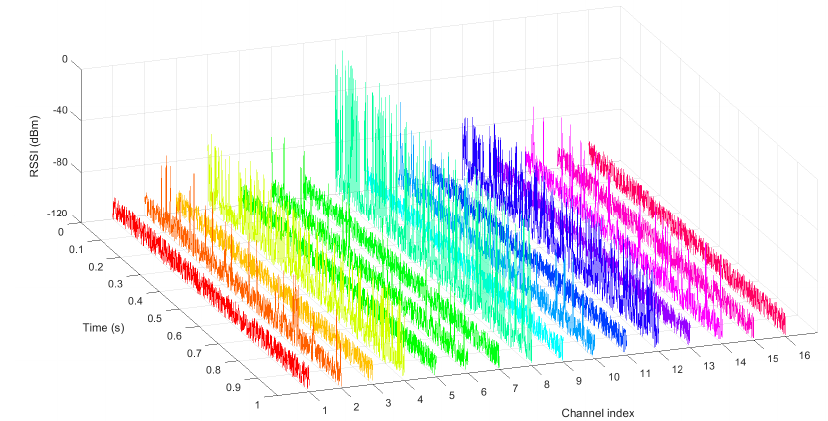
Figure 2. Example of Received Signal Strength Indicator (RSSI) signal over 1 second for an IEEE 802.15.4 network with 16 channels. The RSSI values lie within − 120 dBm and 0 dBm. Higher RSSI values indicate channels interfered to a greater extent, while lower RSSI values indicate channels interfered to a lesser extent.